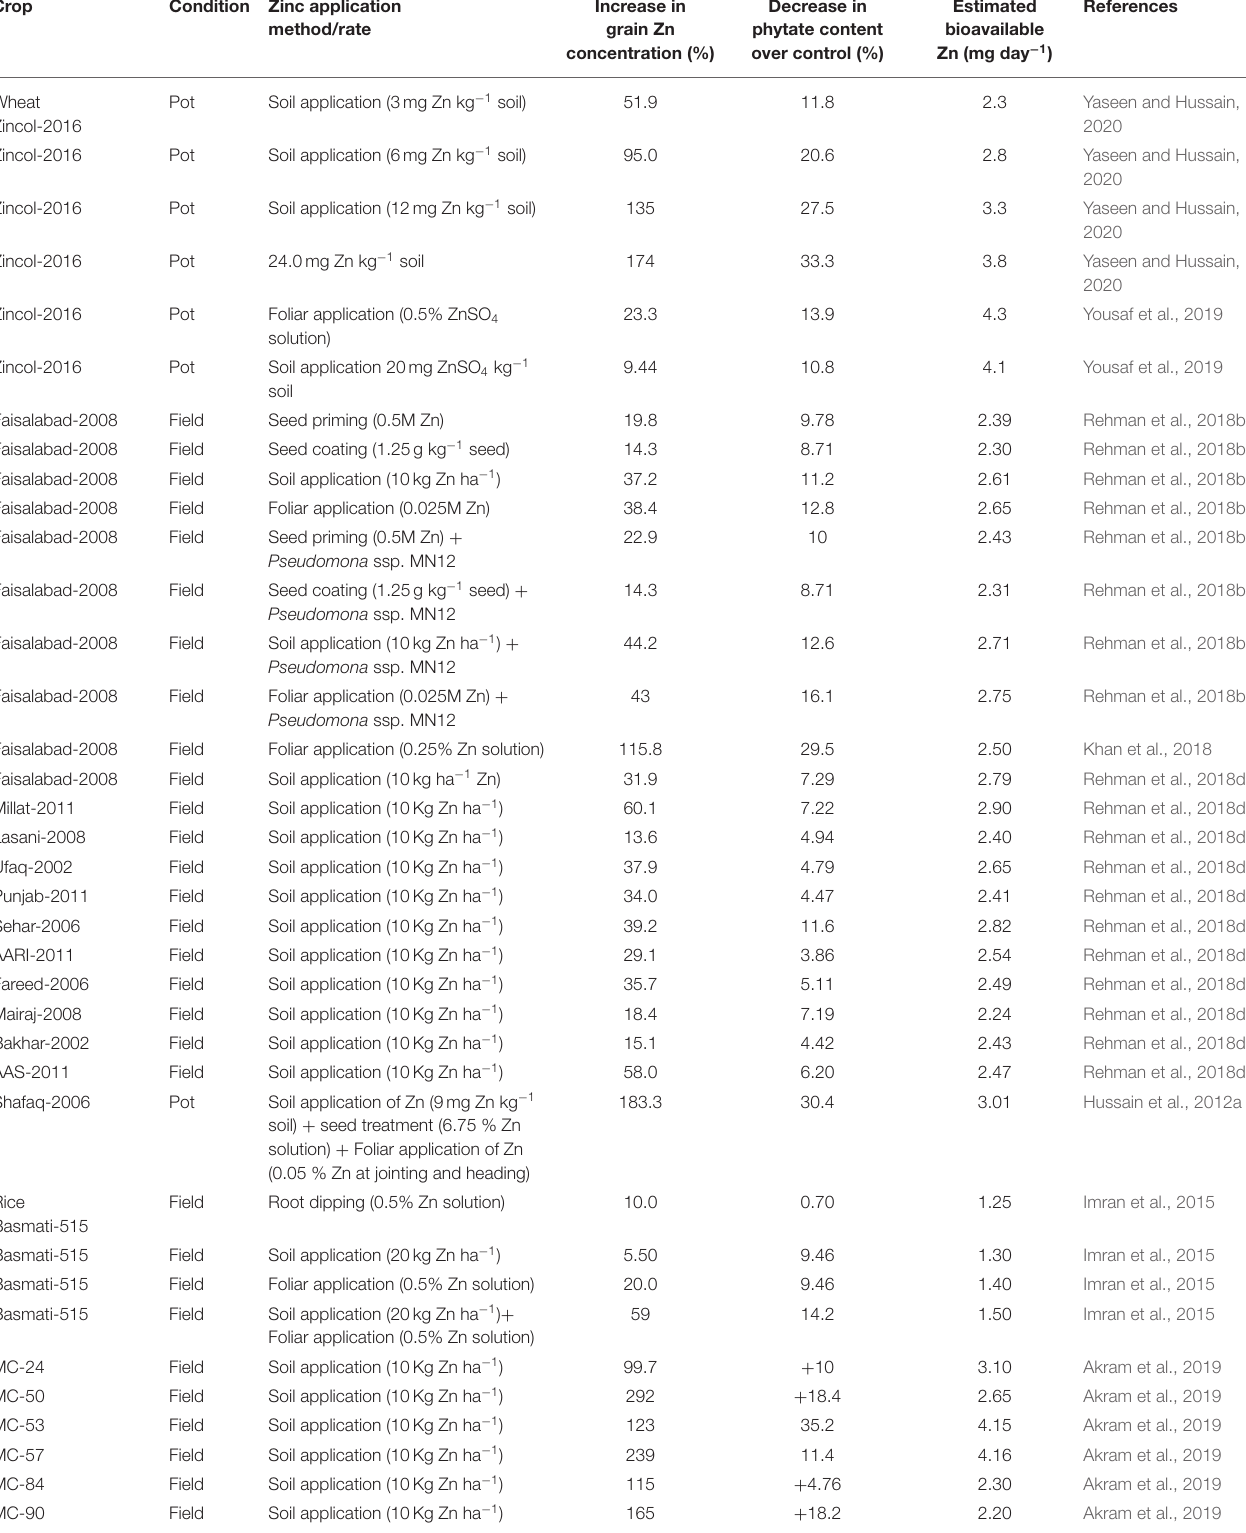
TABLE 1 | Increase in grain Zn concentration and bioavailable Zn in different cereal and grain legume crops with Zn application.